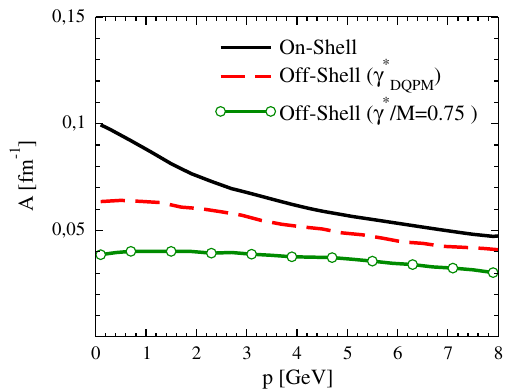
Fig. 6 Drag coefficient ( A ) as a function of momentum for fixed medium temperature at T = 0 . 2 GeV for on-shell approach (black solid line) and off-shell approach (red dashed line). The open green circles refers to the case with larger widths with fixed ratio γ ∗